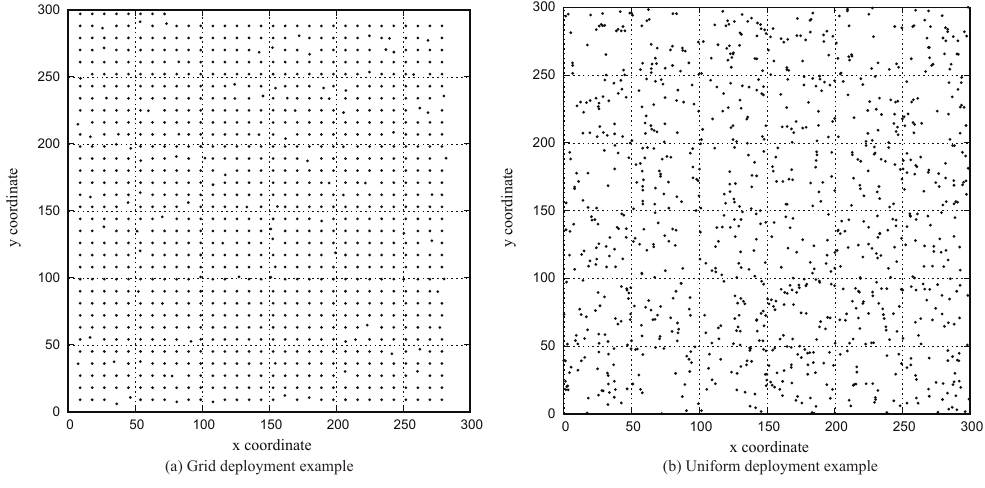
Figure 13. Deployment strategy of sensors in the target zone with 1000 sensors. Ten percent of them are smart attackers, and each attacker fakes its location by about 10